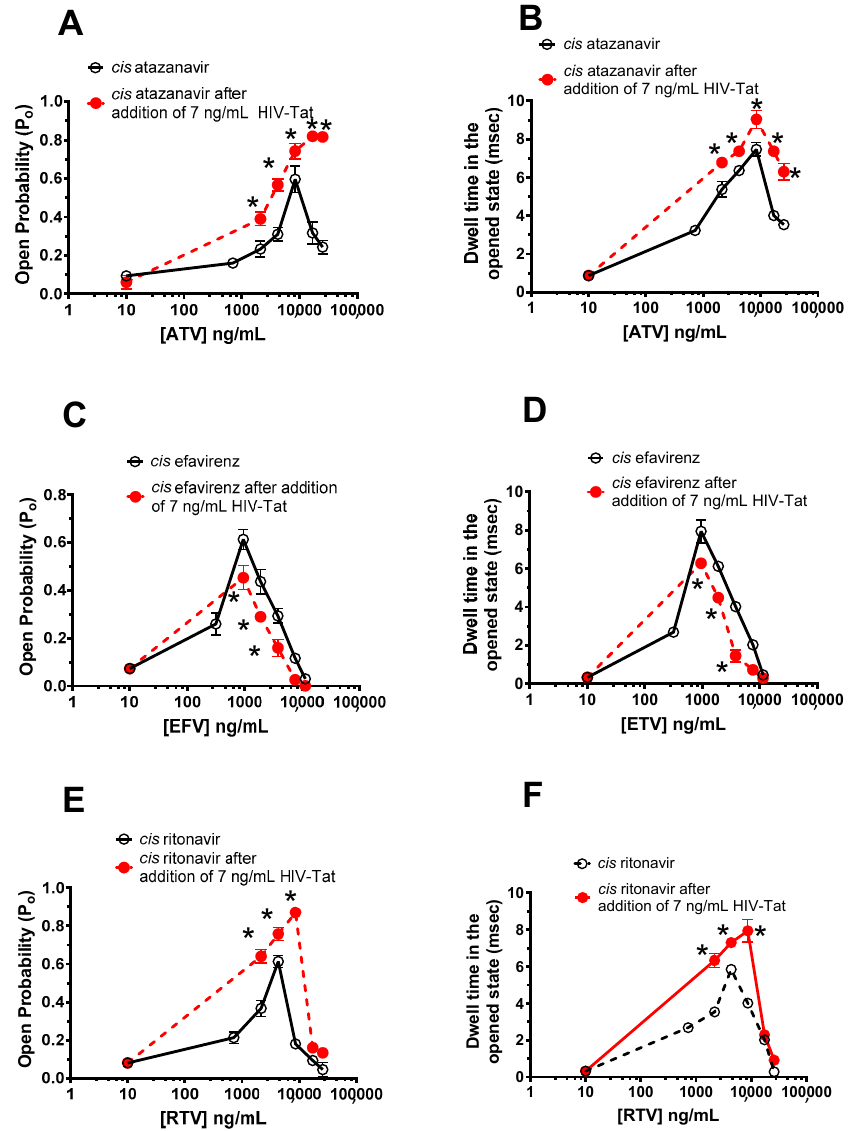
Figure 8. The effects of varying cis concentrations of atazanavir (ATV), efavirenz (EFV), and ritonavir (RTV) on the P o and dwell time in the opened state of RyR2 in the presence and absence of low HIV-Tat (14 ng/mL) . Panels A,B show graphs of the P o and dwell times in the opened state of RyR2 as a function of varying concentrations of cis ATV in the absence ( ○ ) and presence ( ● ) of 7 ng/mL HIV-Tat in the cis chamber. Data shown are mean ± S.E.M for n = 13 channels. Panels C,D show graphs of the P o and dwell times in the opened state of RyR2 as a function of varying concen- trations of cis EFV in the absence ( ○ ) and presence ( ● ) of 7 ng/mL HIV-Tat in the cis chamber. Data shown are mean ± S.E.M for n = 112 channels. Panels E,F show graphs of the P o and dwell times in the opened state of RyR2 as a function of varying concentrations of cis RTV in the absence ( ○ ) and presence ( ● ) of 7 ng/mL HIV-Tat in the cis chamber. Data shown are mean ± S.E.M for n = 11 chan- nels. * denotes significant differences ( p < 0.05) from that in the absence of HIV-Tat. 2.6. In Silico Molecular Docking of HIV-Tat on RyR2